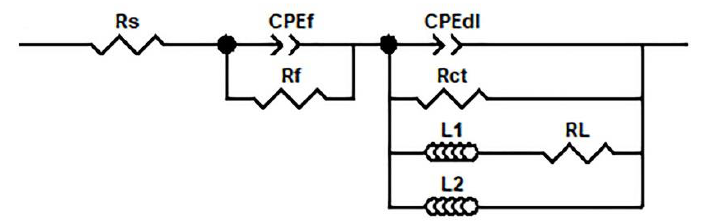
Figure 8. Equivalent electric circuit used to fit the Nyquist plots of HPT-processed and annealed Mg–RE samples. Table 2. Electrochemical parameters obtained from the fits of the experimental Nyquist plots of Mg–RE